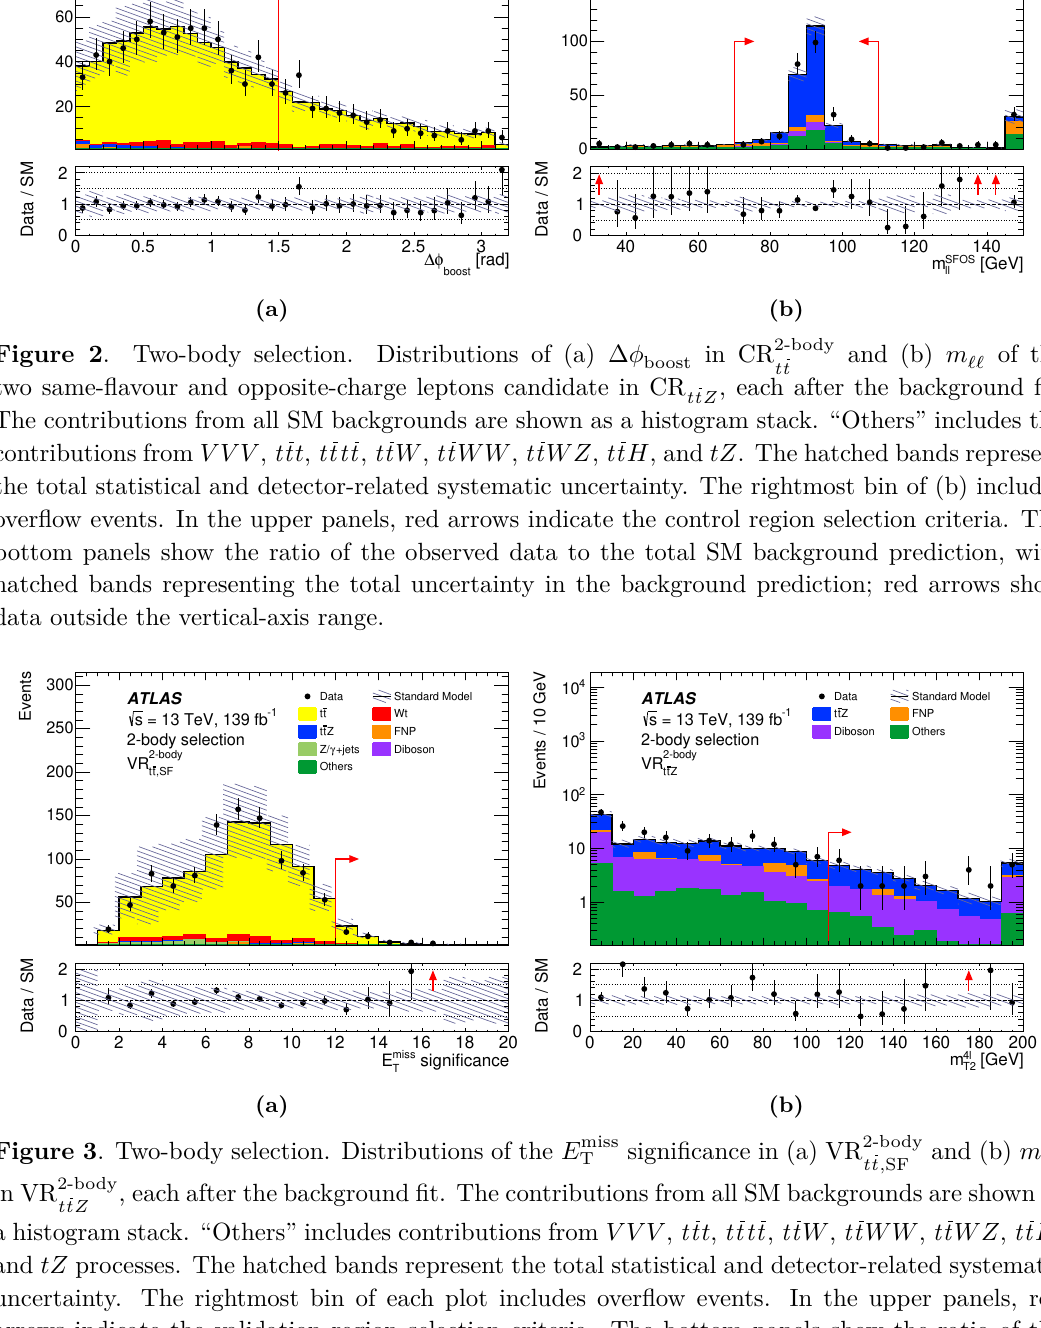
uncertainty. The rightmost bin of each plot includes overflow events. In the upper panels, red arrows indicate the validation region selection criteria. The bottom panels show the ratio of the observed data to the total SM background prediction, with hatched bands representing the total uncertainty in the background prediction; red arrows show data outside the vertical-axis